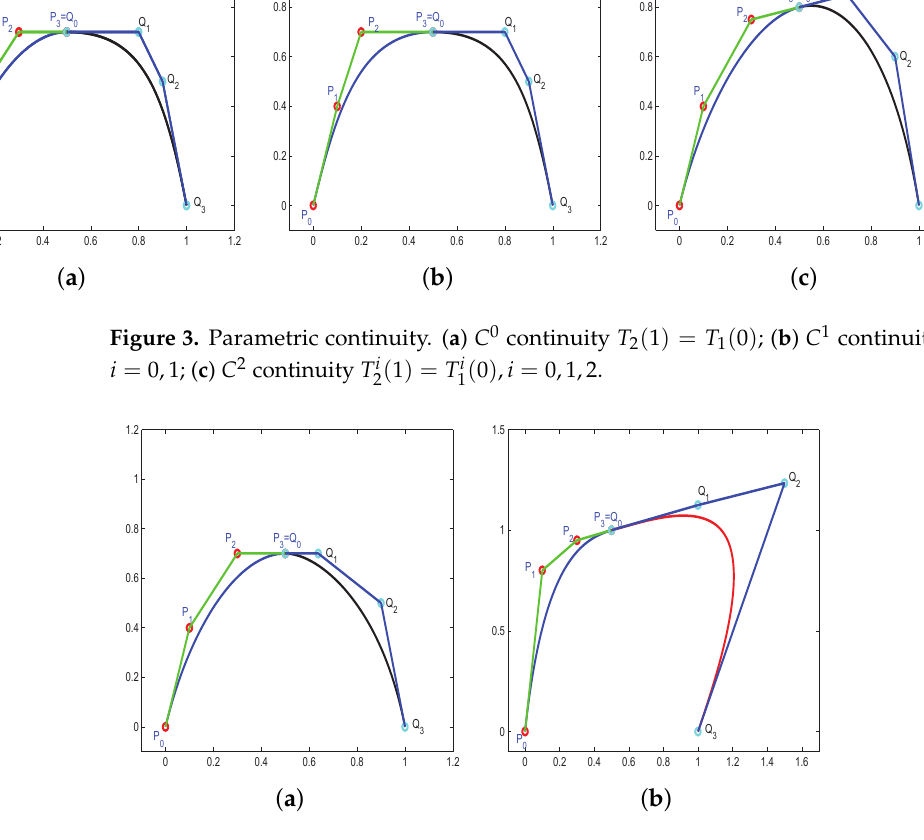
Figure 4. Geometric continuity. ( a ) GC 1 continuity λ = 1.3; ( b ) GC 2 continuity λ = 0.5, γ = 1.2. The above scheme with C 1 continuity has been used for the construction of frontal bone fracture, as shown in Figure 5.